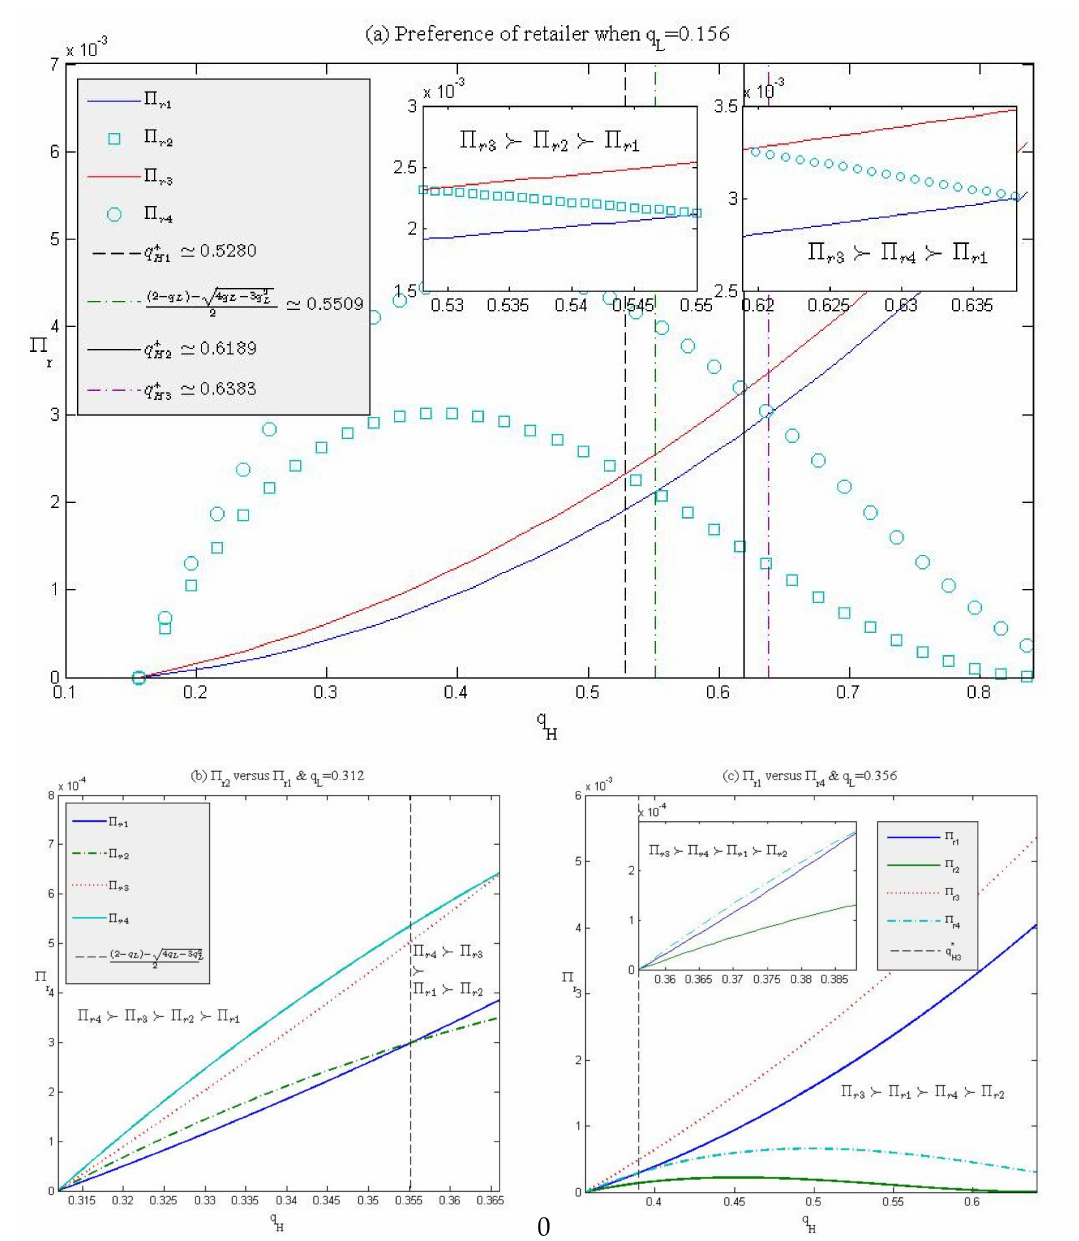
Figure 7. Retailer’s channel structures in different mass